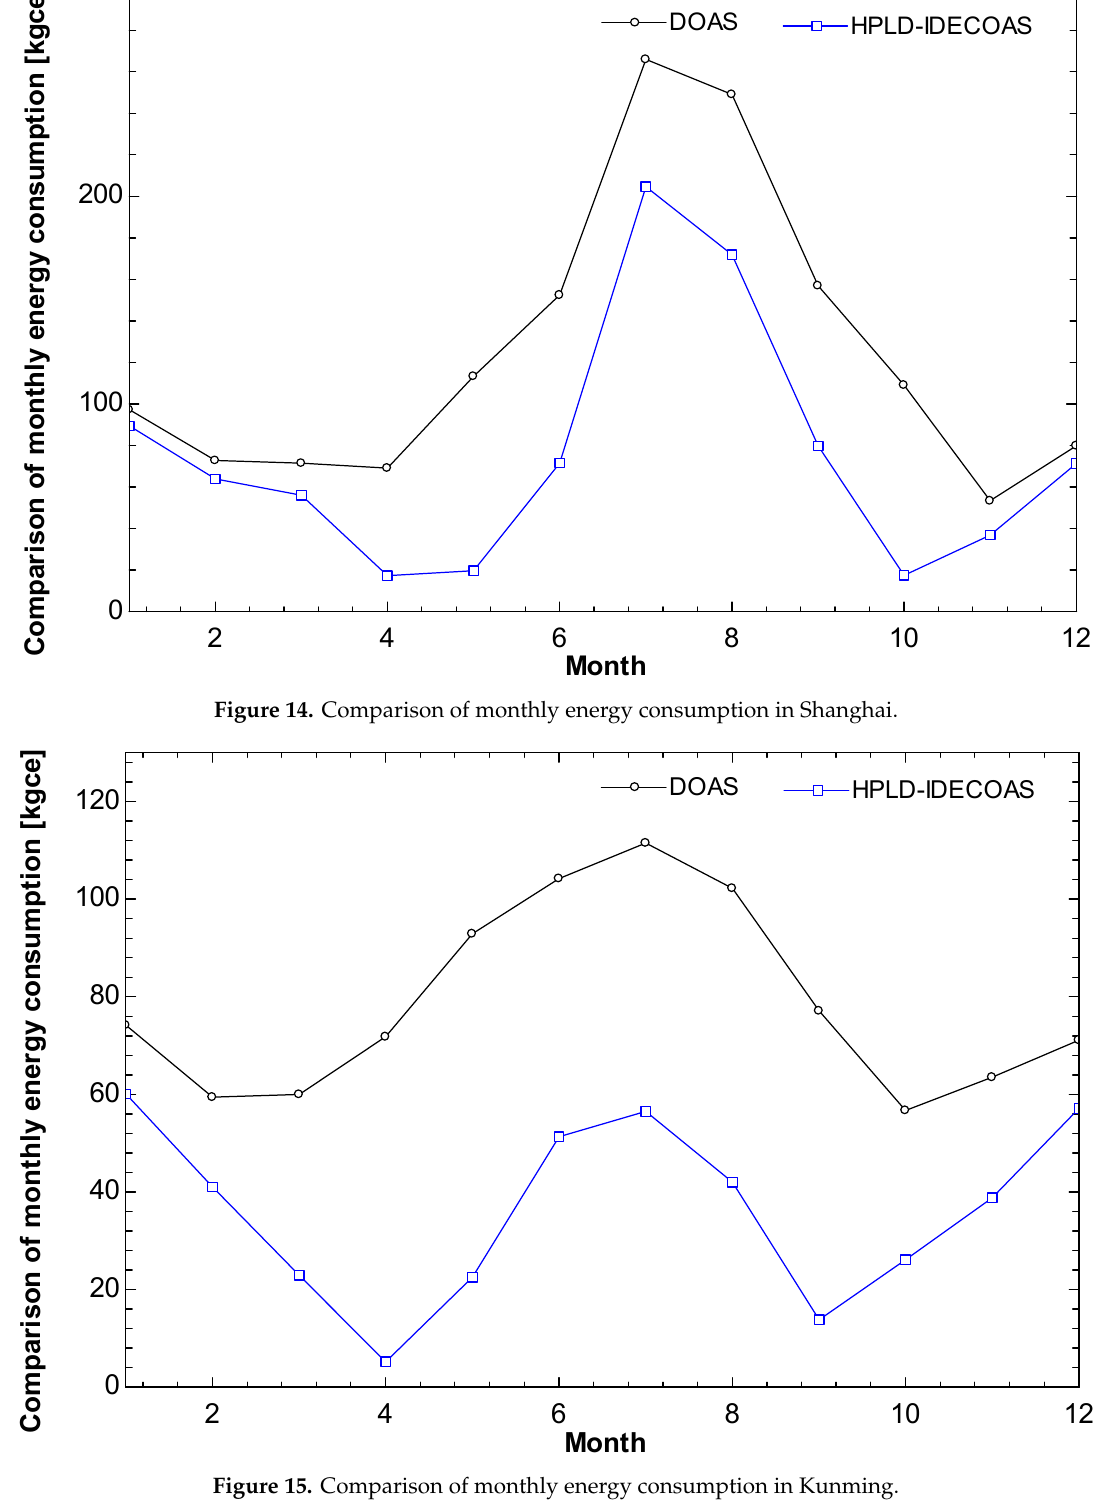
Figure 15. Comparison of monthly energy consumption in Kunming.